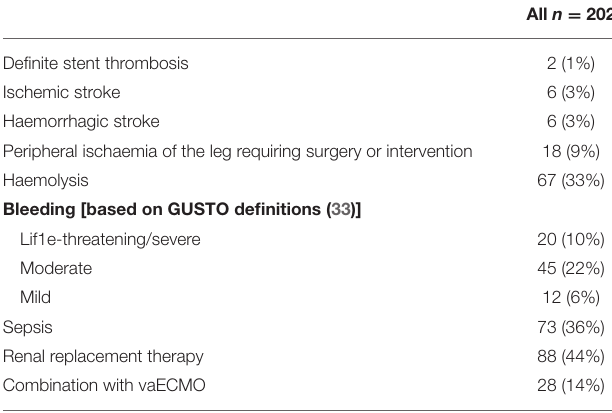
TABLE 2 | Thirty-day adverse